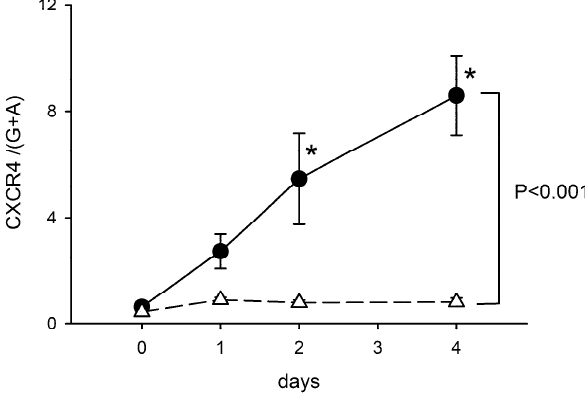
Figure A2. Time-dependent upregulation of CXCR4 after intrastriatal administration of collagenase. The expression of CXCR4 mRNA in the lesioned striatum was significantly increased from D1 to D4. Data for D0 were taken from non-ICH control animals. The expression of CXCR4 was normalized relative to the endogenous reference genes (Beta-actin and GAPDH averages) with a modified delta-delta-Ct algorithm. * p < 0.05, F 3,25 = 5.990, vs. control, Two-way ANOVA + posthoc NK test.